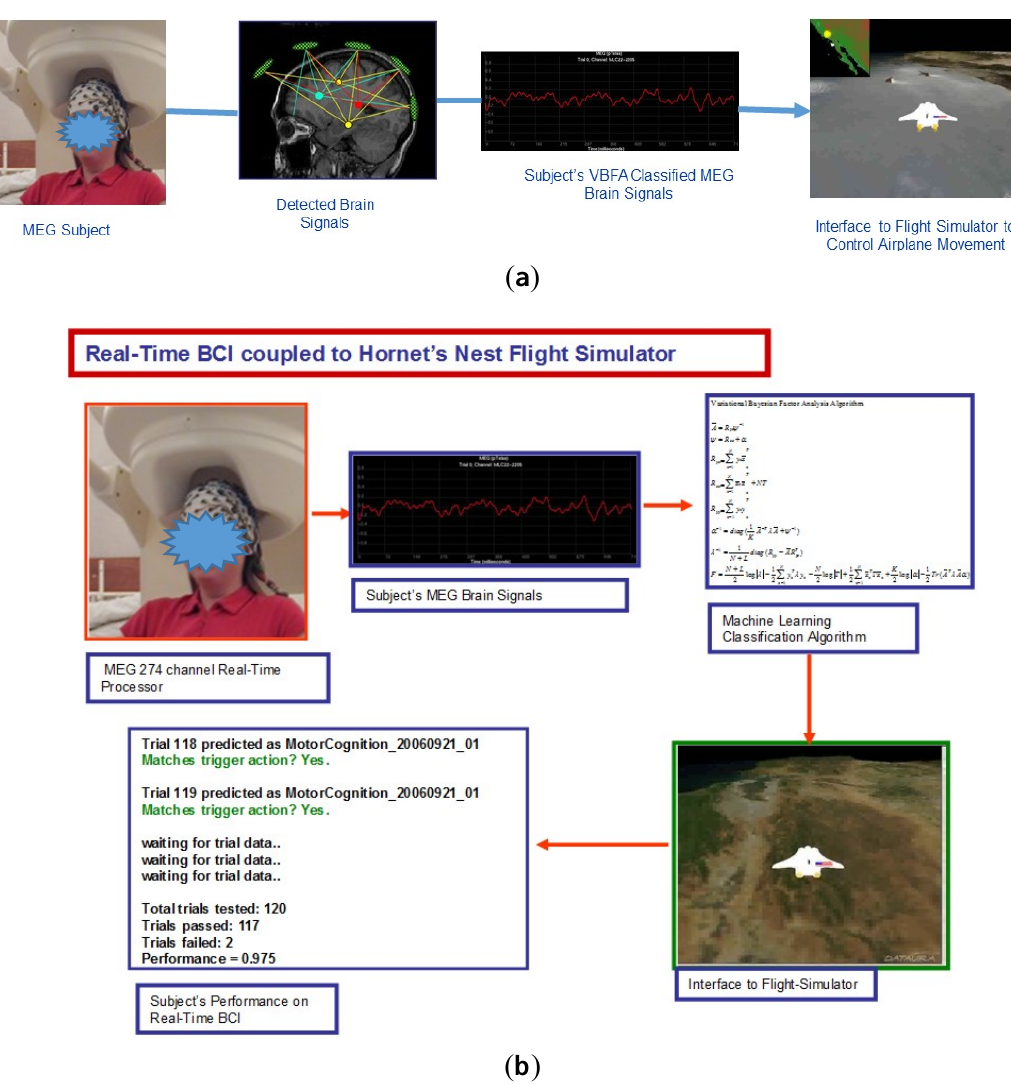
Figure 4. ( a ) MEG Brain Signals Classified with VBFAPerformer and Interfaced to Flight Simulator; ( b ) Real-Time BCI performance of predicted right and left thought-movement